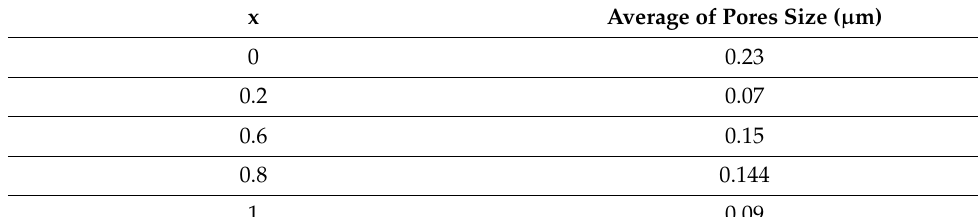
Table 3. Average pores size ( µ m) for Ni + 2